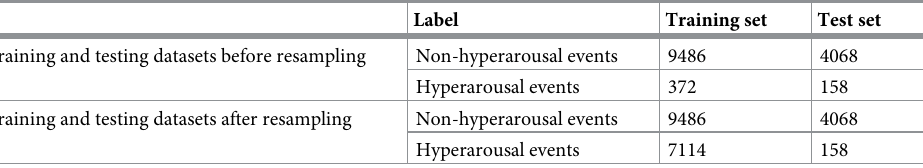
Table 2. Training and testing datasets after and before